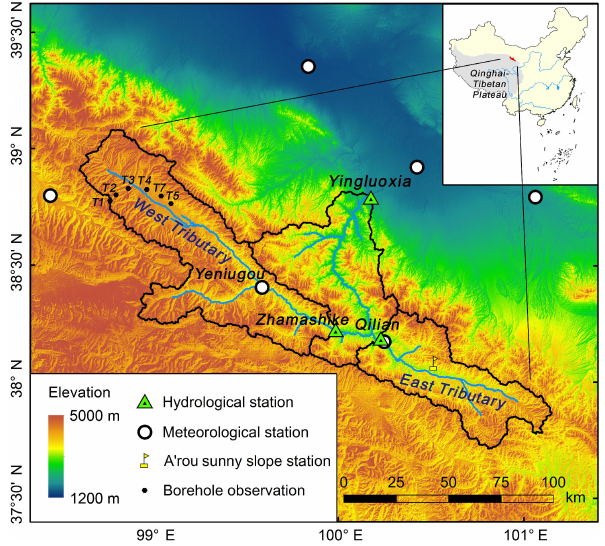
Figure 1. The study area, hydrological stations, borehole observa- tion and flux tower